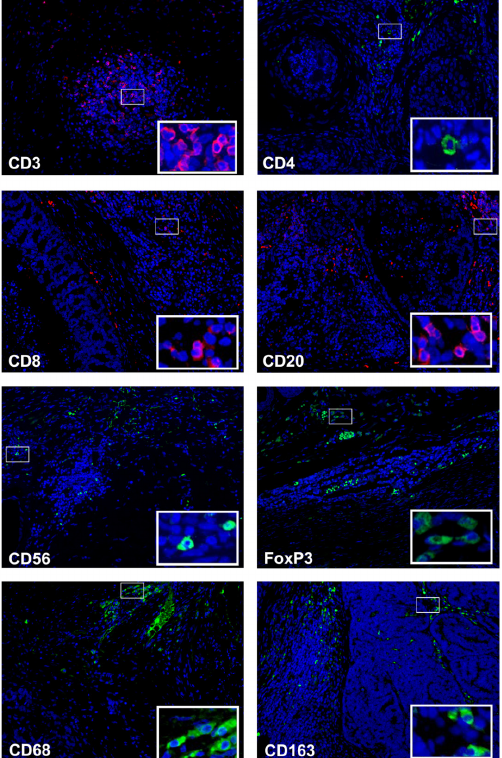
Figure 1. CD3 + tumor infiltrating lymphocytes are the most common immune cells in feline mammary tumor samples. Representative micrographs of immunofluorescence of mammary tumors stained for CD3 + , CD4 + , CD8 + , CD20 + , CD56 + , FoxP3 + , CD68 + and CD163 + ; insets depict high-power magnification of positive cells. Original magnification, 200×.